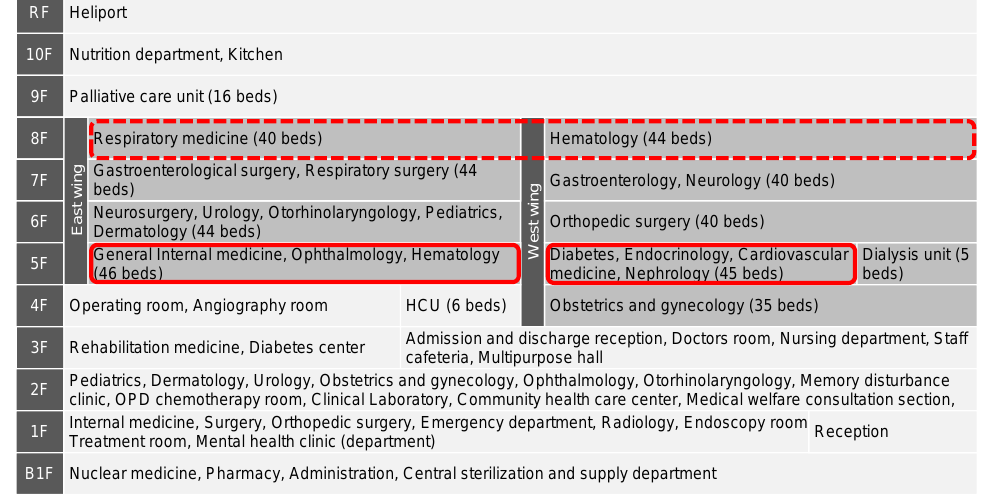
Figure 3. Ward map and major sources of COVID-19 infection of Hospital A. Shaded parts indicate the wards that became infected zone. The west wing of the fifth floor was the ward in which the first case was found and spread to the east wing. The dotted line on the eighth floor indicates the wards that became the second center of infection. Authors made based on the hospital website, http://www.eijuhp.com/floor_guide.html, accessed on 1 April 2021. HCUs, high care unit; OPD, outpatient department.